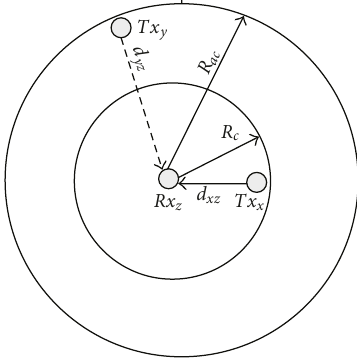
Figure 1: Model to drive the pdf of the SIR from a single neighboring